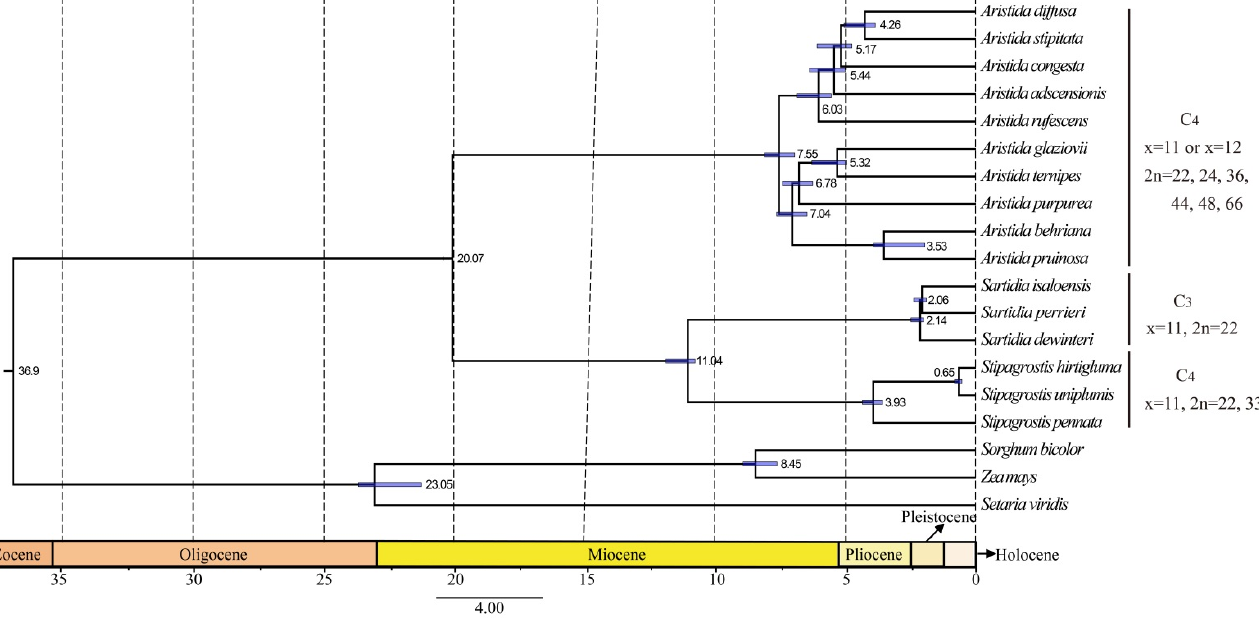
Figure 8. Chronogram constructed from treePL divergence estimation analysis. The short blue bar represents 95% confidence interval.